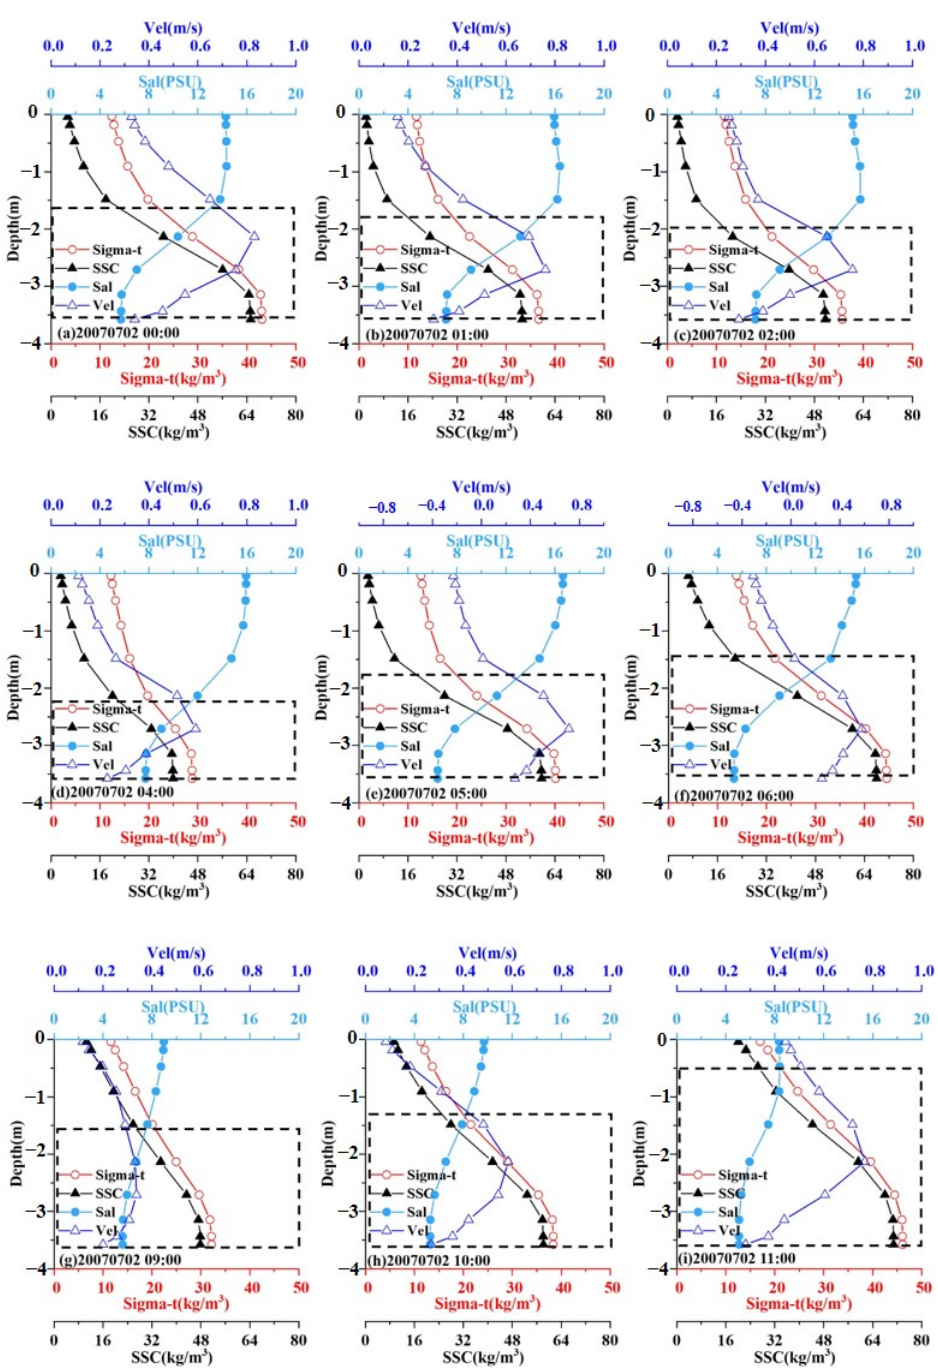
Figure 9. Vertical profiles of excess bulk density (sigma-t), suspended sediment concentration (SSC), salinity (sal), and velocity (vel) in the station S1 at different times. Note that station S1 is shown in Figure 1b and the black dash lines indicate the hyperpycnal layer. ( a ) 00:00 ( b ) 01:00 ( c ) 02:00 ( d ) 04:00 ( e ) 05:00 ( f ) 06:00 ( g ) 09:00 ( h ) 10:00 ( i ) 11:00 on 2 July